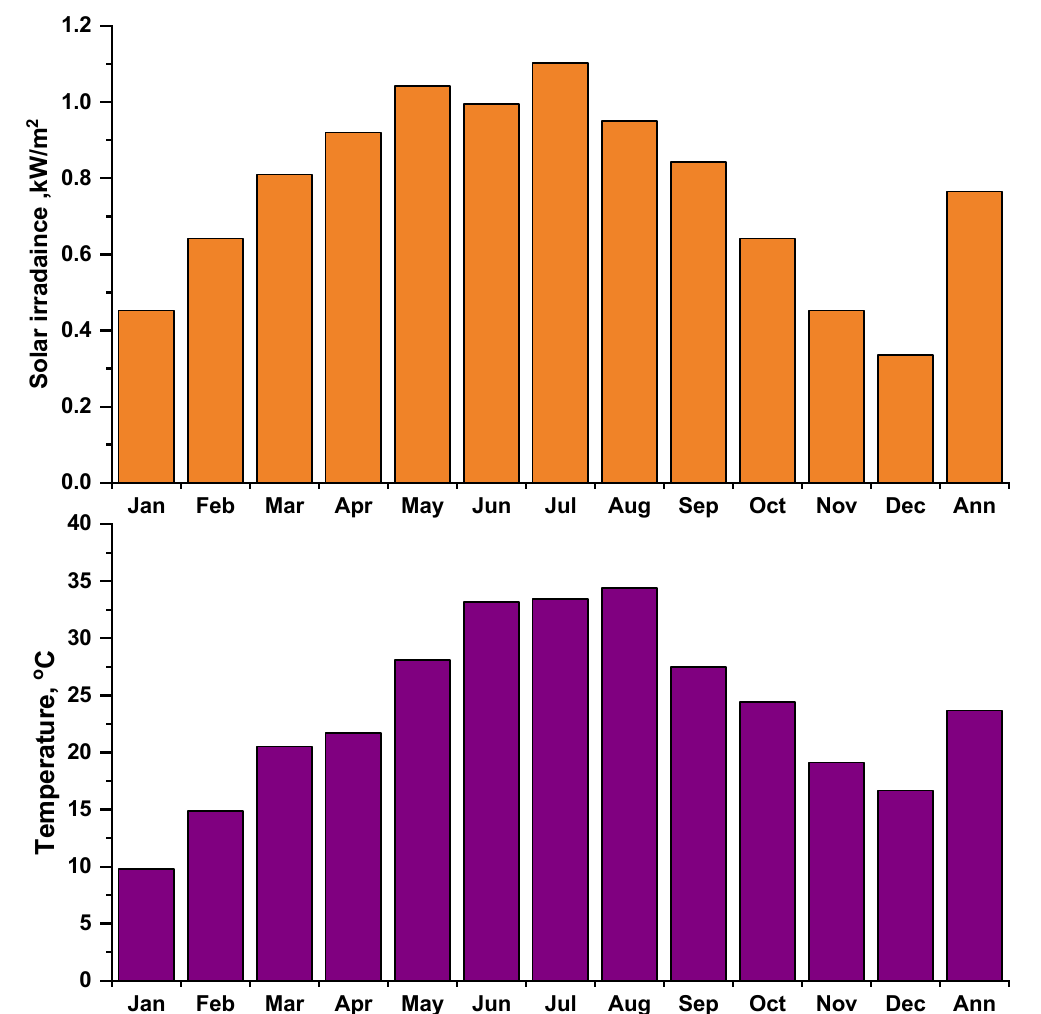
Figure 4. Monthly average experimental solar irradiance and ambient temperature.